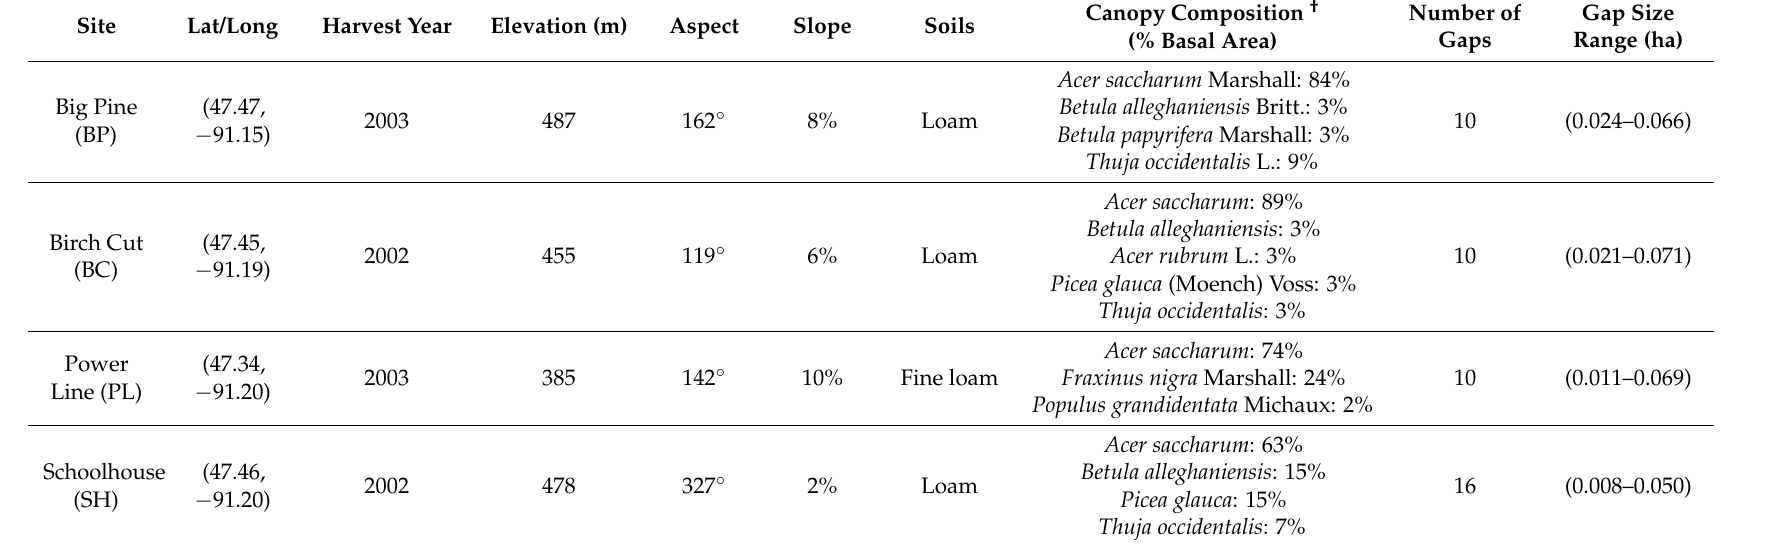
Table 1. Physiographic and compositional characteristics of the study sites in Northeastern Minnesota,